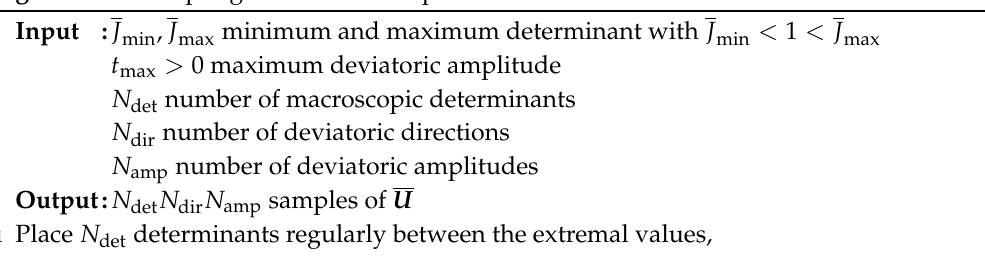
Algorithm 1: Sampling of the macroscopic stretch